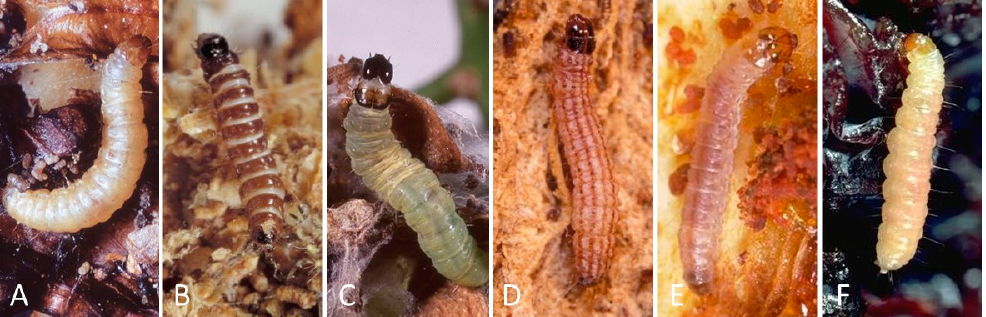
Figure 1. Examples of some of the moth larvae tested, with photos of the fifth instars, which are more easily separated visibly from each other ( A ) navel orangeworm, ( B ) peach twig borer, ( C ) obliquebanded leafroller, ( D ) raisin moth, ( E ) omnivorous leafroller, and ( F ) Indian meal moth. Earlier stages, especially first and second instars, are more difficult to distinguish.